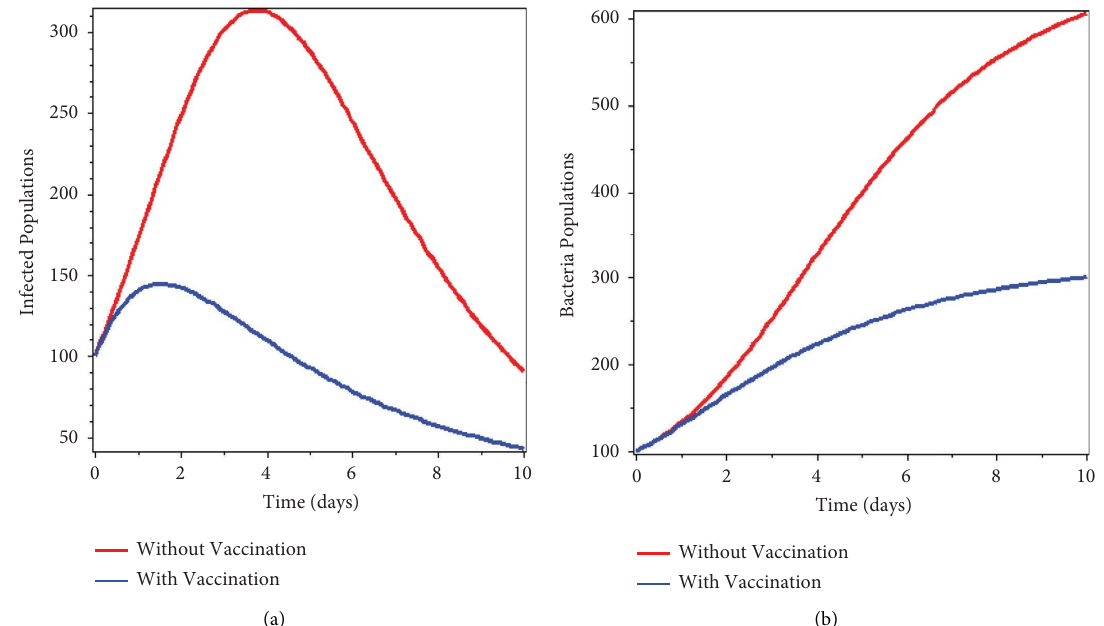
Figure 7: Efect of vaccination on the infected human population and bacteria